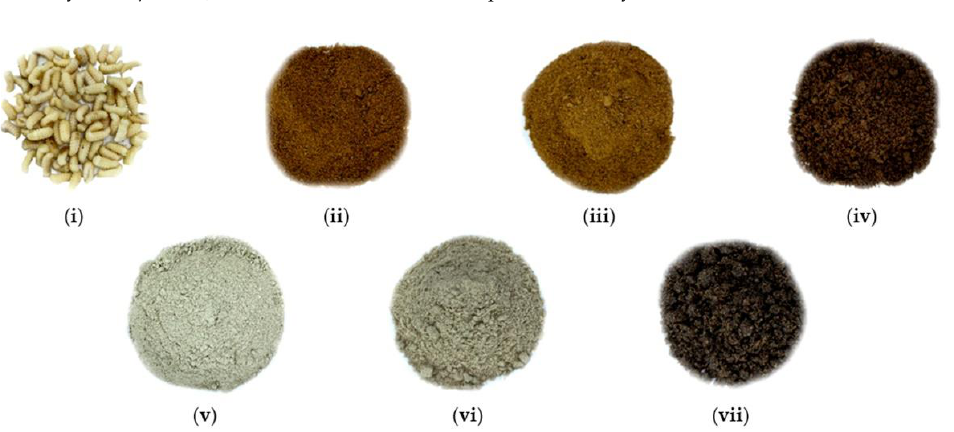
Values are mean ± SD. Different letters (a–g) in each column indicate significant differences among the means by the Tukey’s test ( p < 0.05). VCI indicates the volatile component intensity.